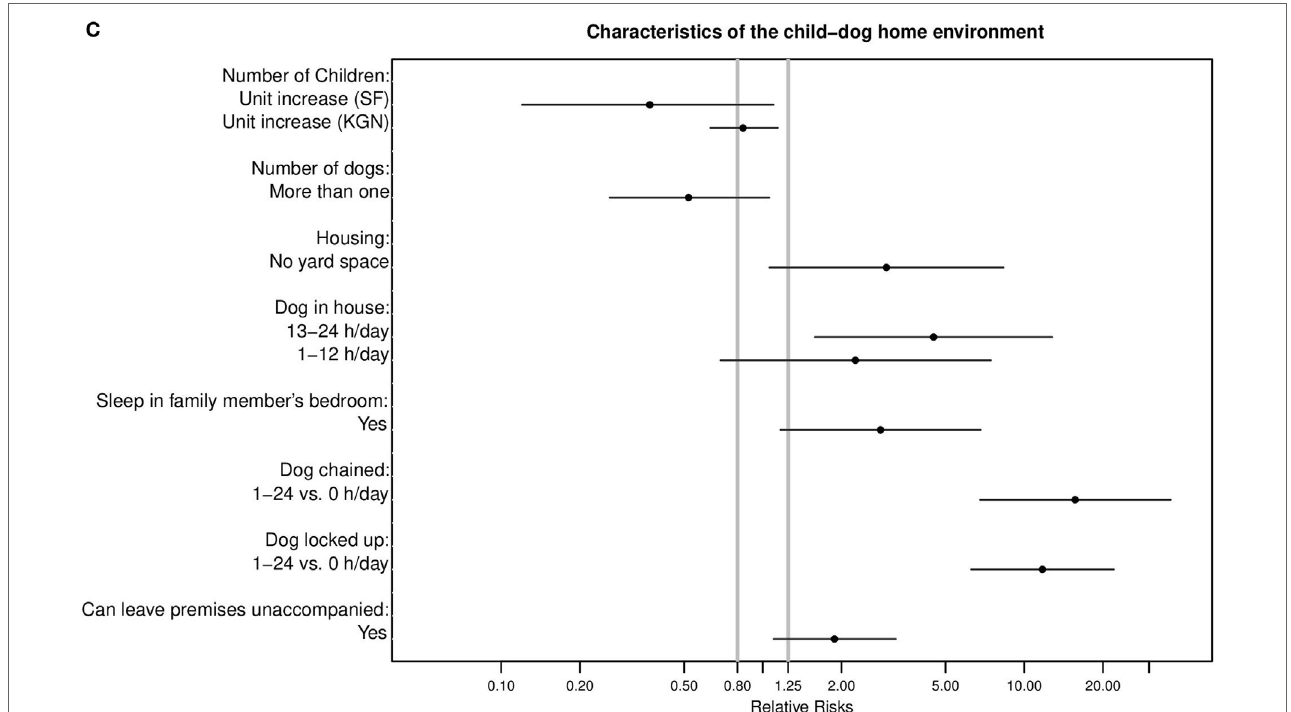
FigUre 3 | Location of relative risk estimates and associated 95% confidence intervals for bites to a child by a dog living in the same home with respect to threshold values of RR = 0.8 and 1.25 by (a) characteristics of the child and child–dog interactions, (B) characteristics of the dog, and (c) characteristics of the child − dog home environment.